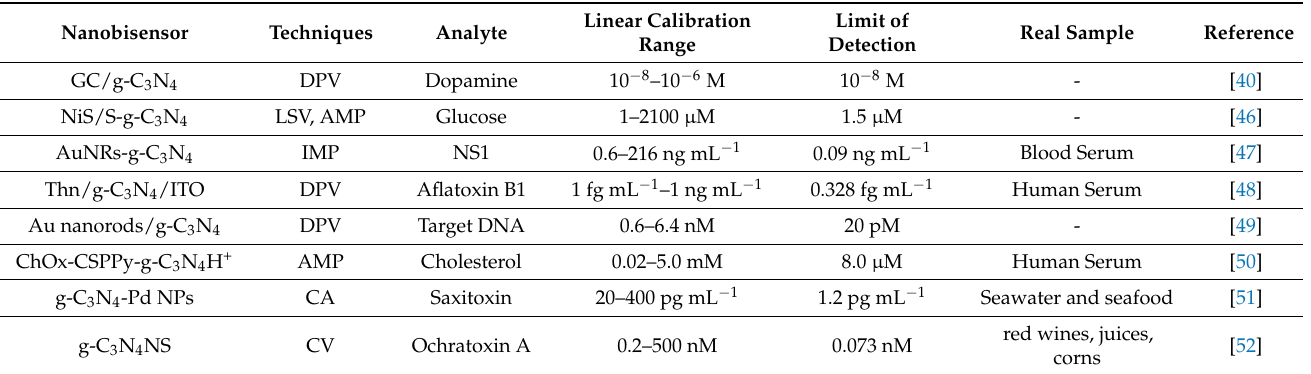
Table 1. Summary of discussed graphitic carbon nitride-based nanobiosensors with electroanalytical